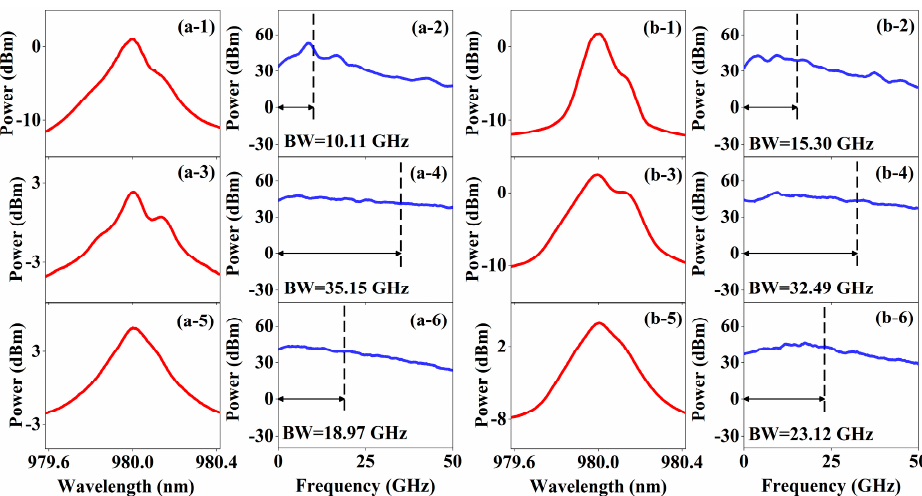
Figure 6. The optical spectra and frequency spectra of the ( a ) XP mode and ( b ) YP mode of the mode of the VCSEL1. ( a-1 , a-2 ) and ( b-1 , b-2 ) k inj = 10 ns − 1 and ∆ f = 40 GHz; ( a-3 , a-4 ) and VCSEL1. ( a-1 , a-2 ) and ( b-1 , b-2 ) k inj = 10 ns − 1 and Δ f = 40 GHz; ( a-3 , a-4 ) and ( b-3 , b-4 ) k inj = 80 ns − 1 and Δ f = 40 GHz; ( a-5 , a-6 ) and ( b-5 , b-6 ) k inj = 300 ns − 1 and Δ f = 40 GHz. ( b-3 , b-4 ) k inj = 80 ns − 1 and ∆ f = 40 GHz; ( a-5 , a-6 ) and ( b-5 , b-6 ) k inj = 300 ns − 1 and ∆ f = 40